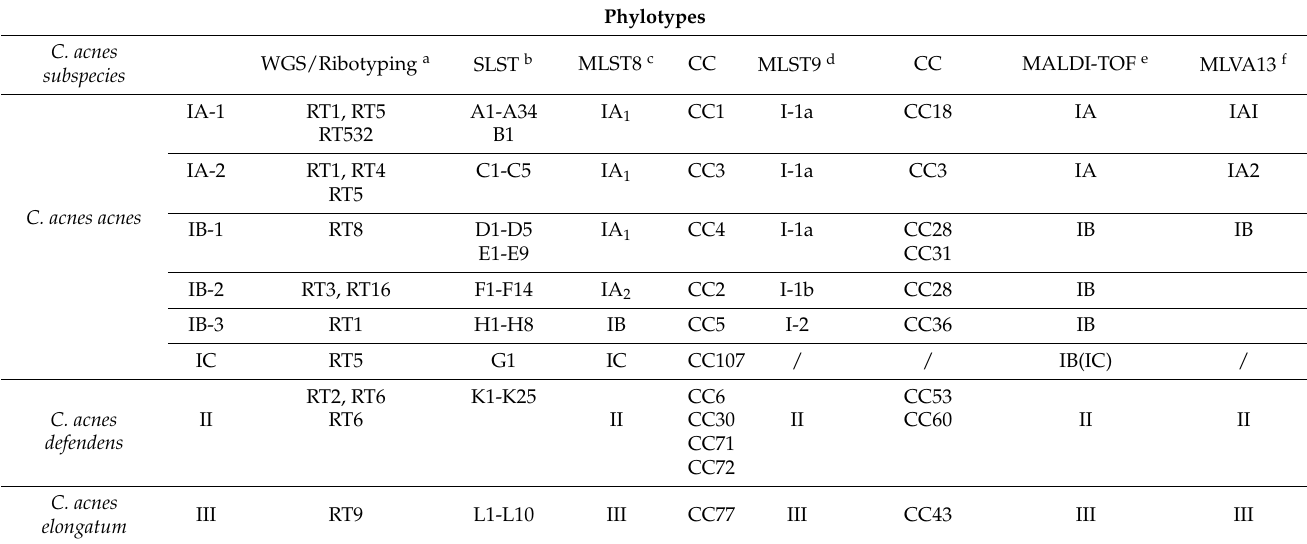
Table 1. C. acnes